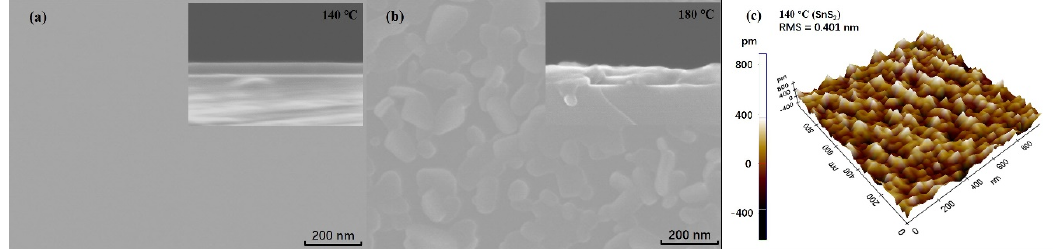
Figure 2. SEM micrographs of the Sn x S y films deposited at ( a ) 140 °C and ( b ) 180 °C on the Si wafer. The insets show the cross sections of the Sn x S y films. ( c ) Atomic force microscopy (AFM) micrograph of the surface of the Sn x S y film grown at 140 °C on the Si wafer. The root mean square roughness is 0.401 nm.